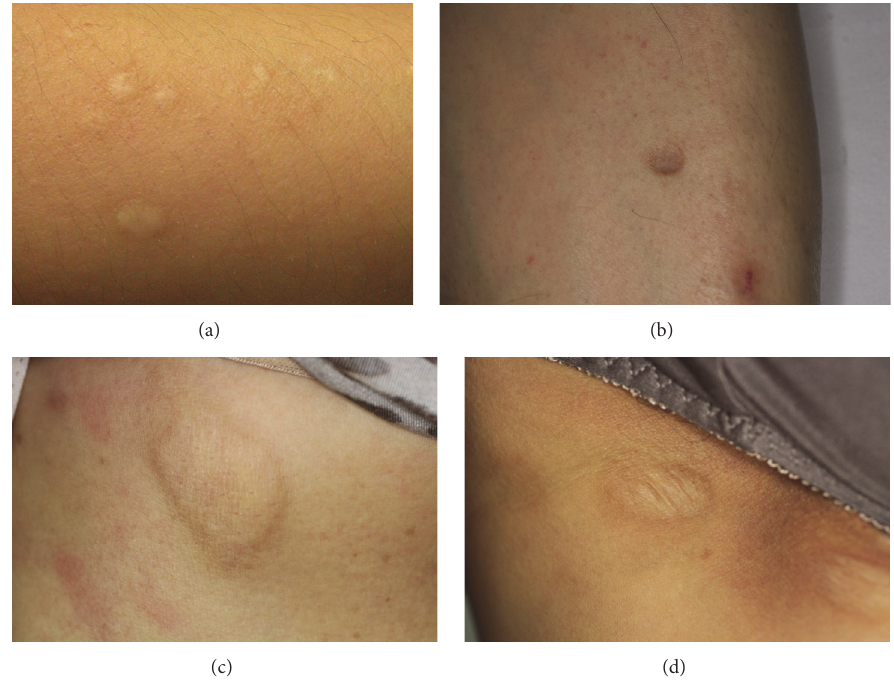
Figure 1: (a) Clinical photo of protruding anetoderma lesions, (b) indented anetoderma lesions, (c) protruding anetoderma lesions of another patient, and (d) indented anetoderma lesions simultaneously found in the same patients who had the protruding lesions shown in